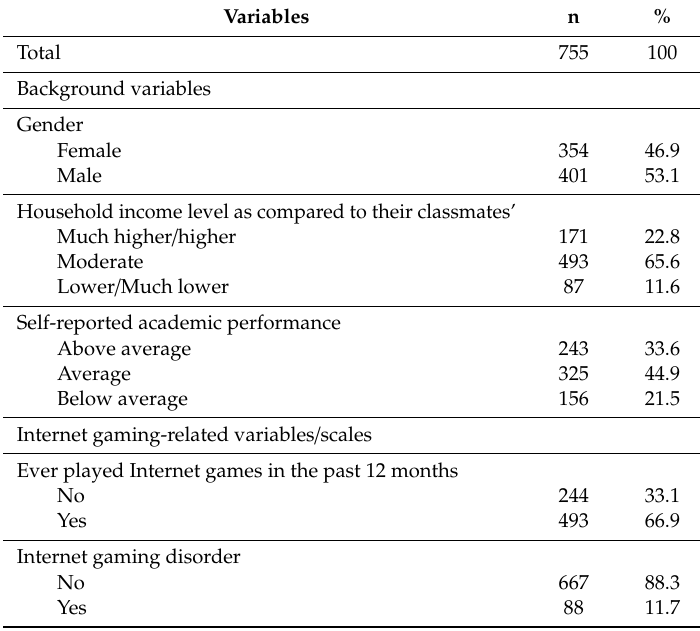
Table 1. Characteristics of participants in the present